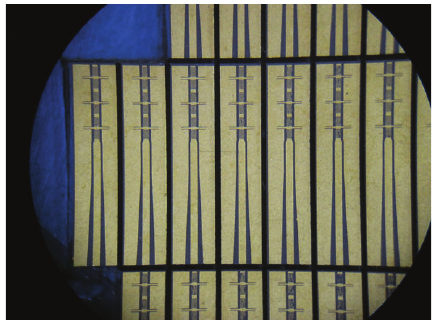
Figure 2: Processed ferrite substrate supporting antenna structures ready to be used in the return loss and resonant frequency measure- ments.